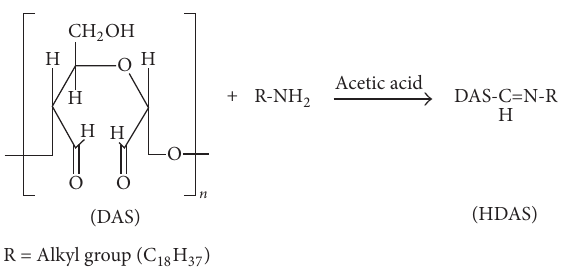
Scheme 1: Preparation process of HDAS.